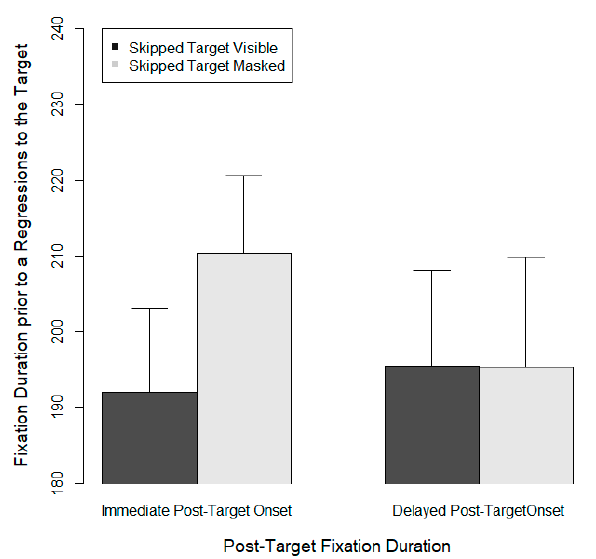
Figure 3. Fixation durations on post-target words prior to a regression to a skipped target word. Fixation durations and standard errors are shown as a function of the visibility of the skipped target and the timeline of post-target onset.